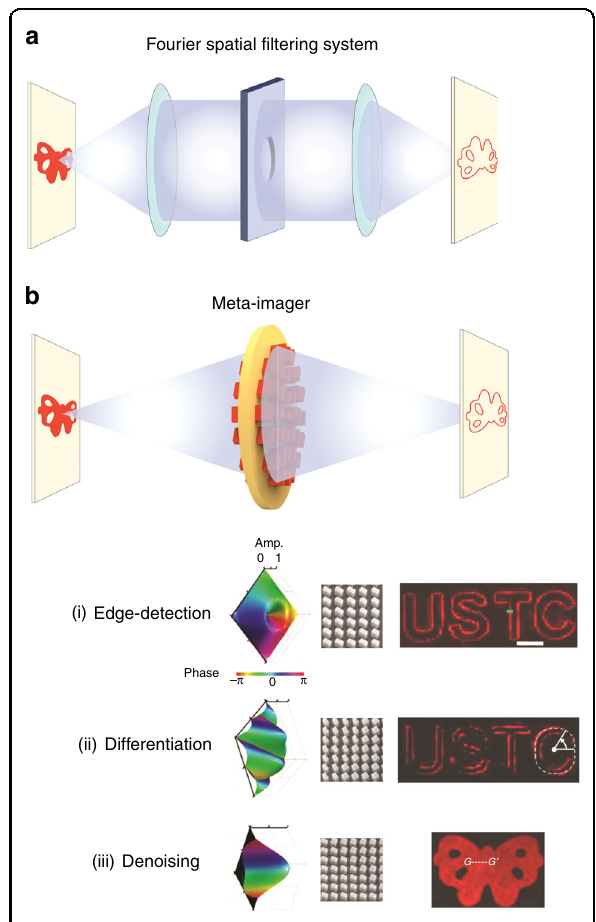
Fig. 1 Schematics of optical image processing system. a Schematic of a Fourier spatial fi ltering system. b Schematic of a meta-imager, (i – iii) edge-detection, differentiation, and denoising with a meta-imager, (From left to right) phase and amplitude contours of a meta-modulator, SEM images of the fabricated meta-modulator, and measured images (scalebar: 50 μ m) reproduced from ref.